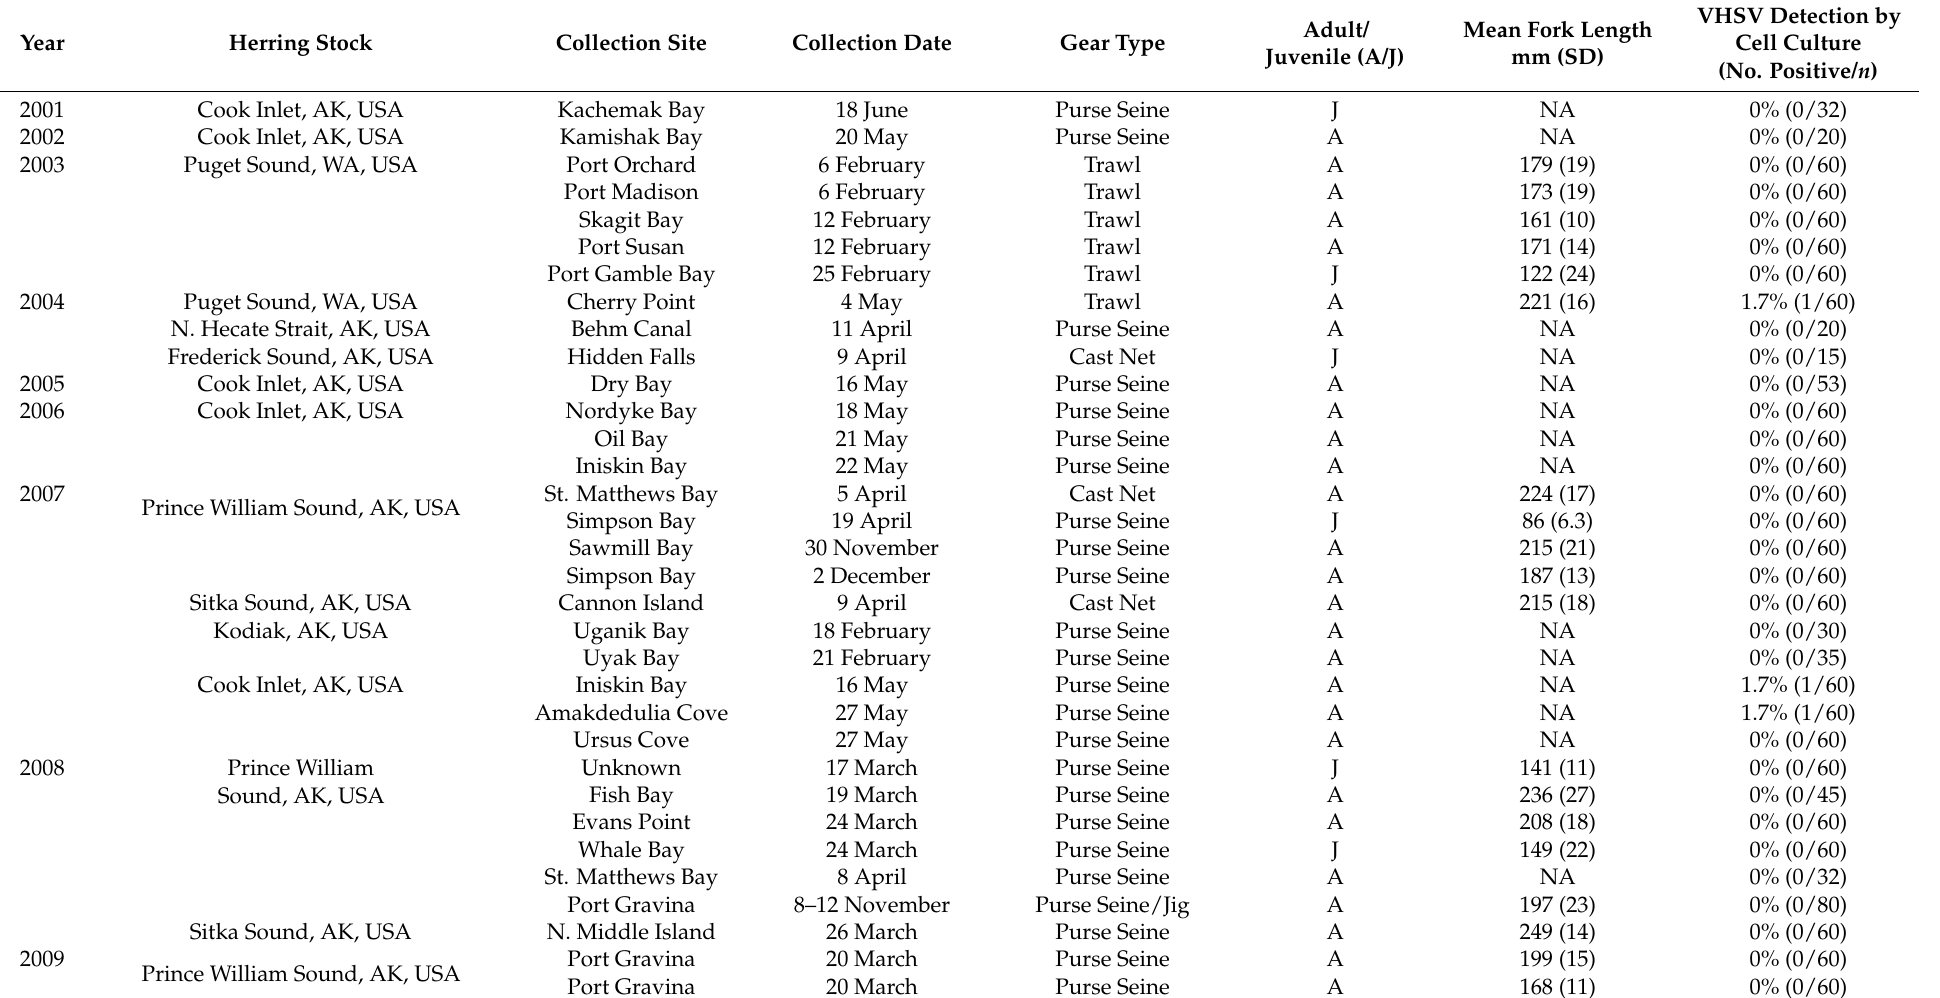
Table 1. Voral hemorrhagic septicemia (VHSV) virus survey results from Pacific herring C. pallasii during typical endemic